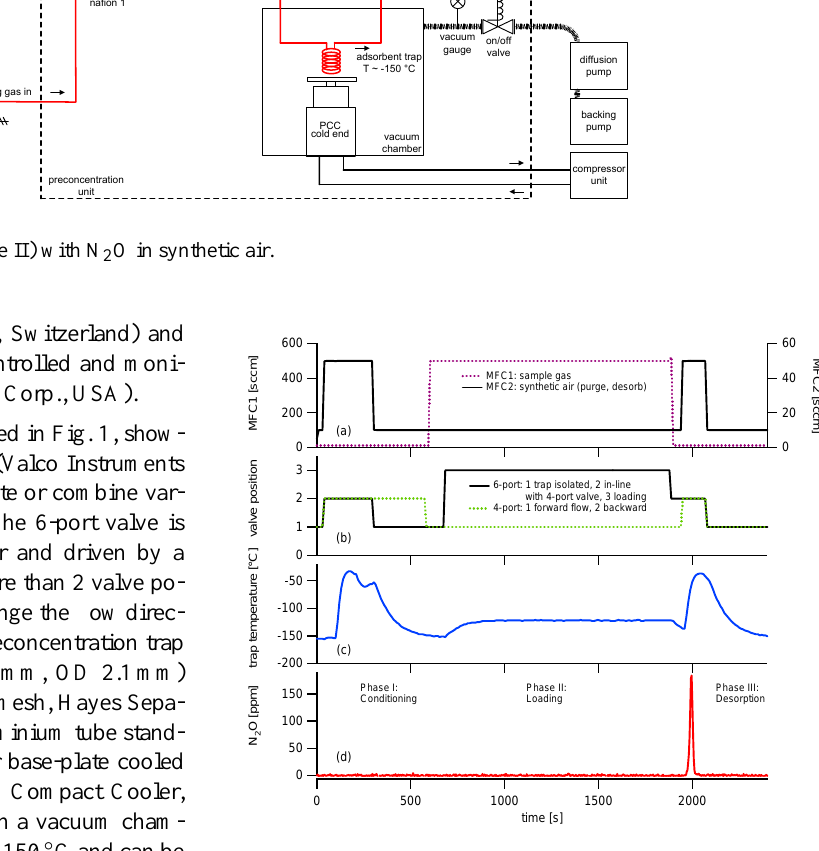
Fig. 2. Typical N 2 O adsorption/desorption process (adsorption of 500 sccm of 350ppb N 2 O in synthetic air; 10l sample volume) with preceding trap conditioning: (a) sample gas flow (MFC1) and flow of synthetic air (MFC2); (b) position of 6-port and 4-port valves; (c) trap temperature; (d) N 2 O mixing ratios as analyzed by on-line FTIR spectroscopy.